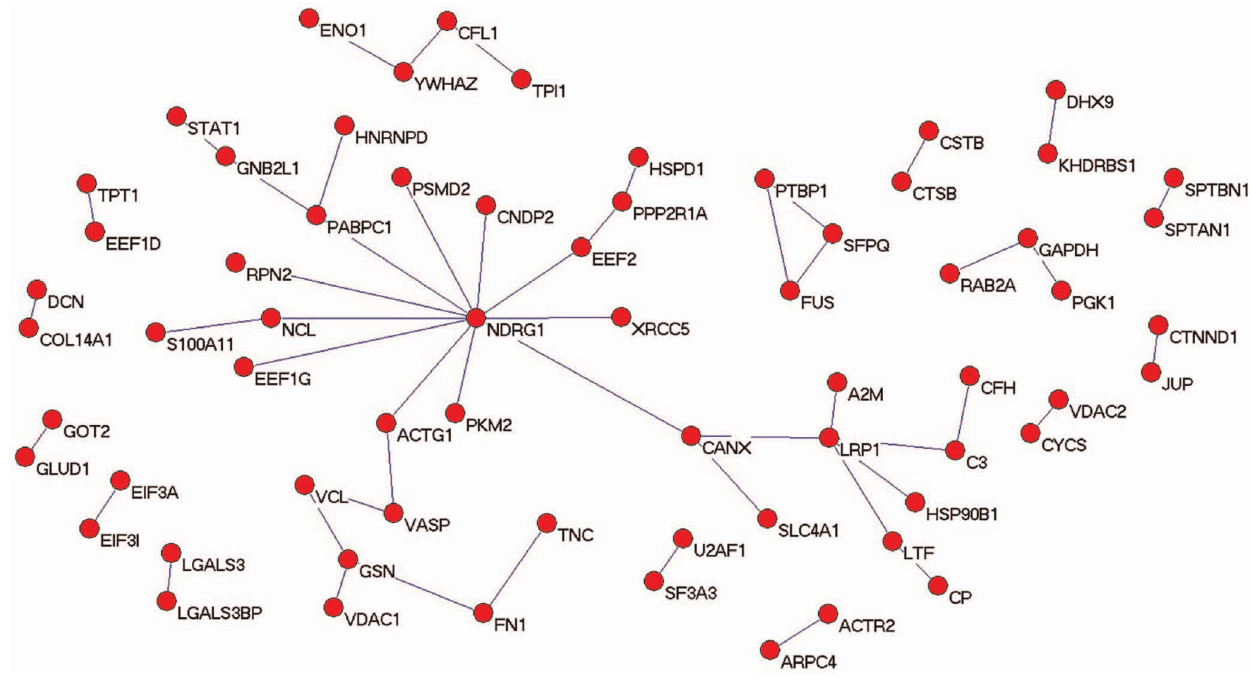
Figure 3. Protein network analysis. The protein–protein interaction network of differential proteins is shown.